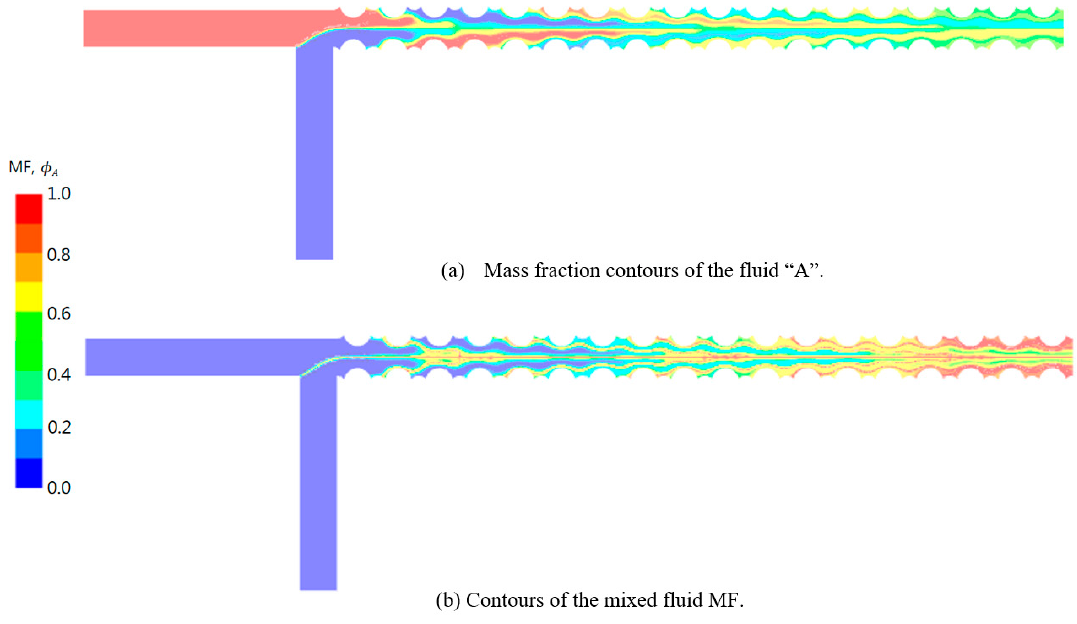
( b ) MC vs. twisting angle Figure 10. Effects of length of the outlet branch on mixing. 6. Conclusions This study numerically examined the effects of channel wall twisting on the mixing performance of a T-shaped microchannel. The performance was evaluated by examining the DOM and the MC. The channel walls were twisted continuously from the junction of the two inlet branches to the outlet, and the twist angle of the cross section increases continuously. This twisting scheme is easy to fabricate and very effective for improving the DOM.